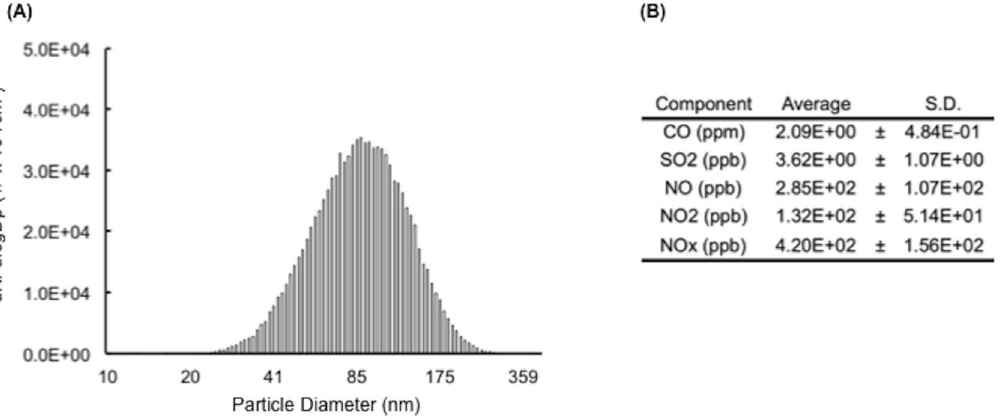
Figure 2. Characterization of diesel exhaust. (A) Particle diameter distribution of diesel exhaust particles. (B) Concentrations of gaseous